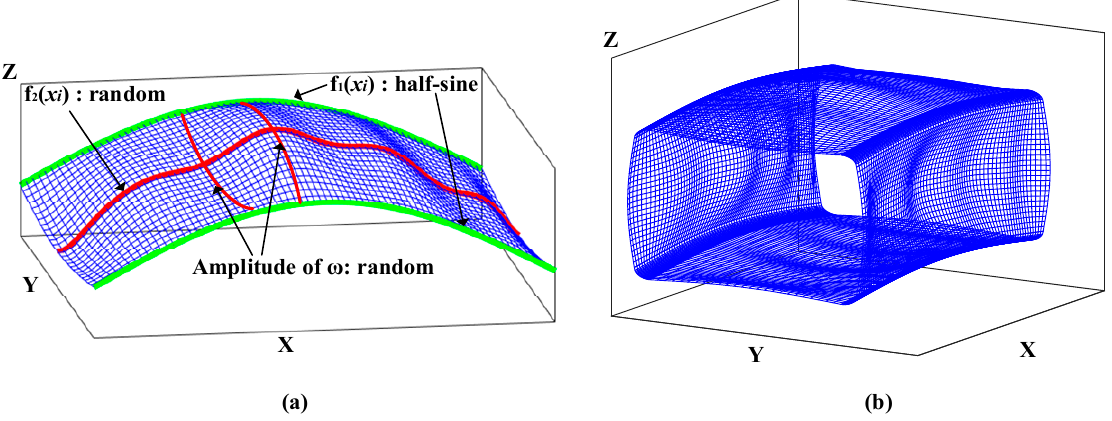
Figure 8. Generated 3D model. ( a ) Surface with random ω and half-sine edges; ( b ) member with random ω and half-sine edges.